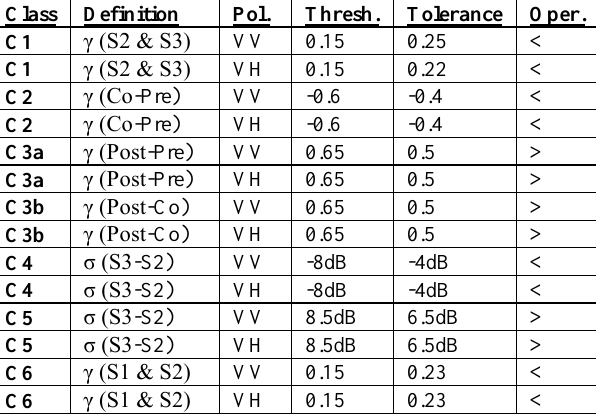
Table 2. Class Thresholds and Tolerances for each polarization